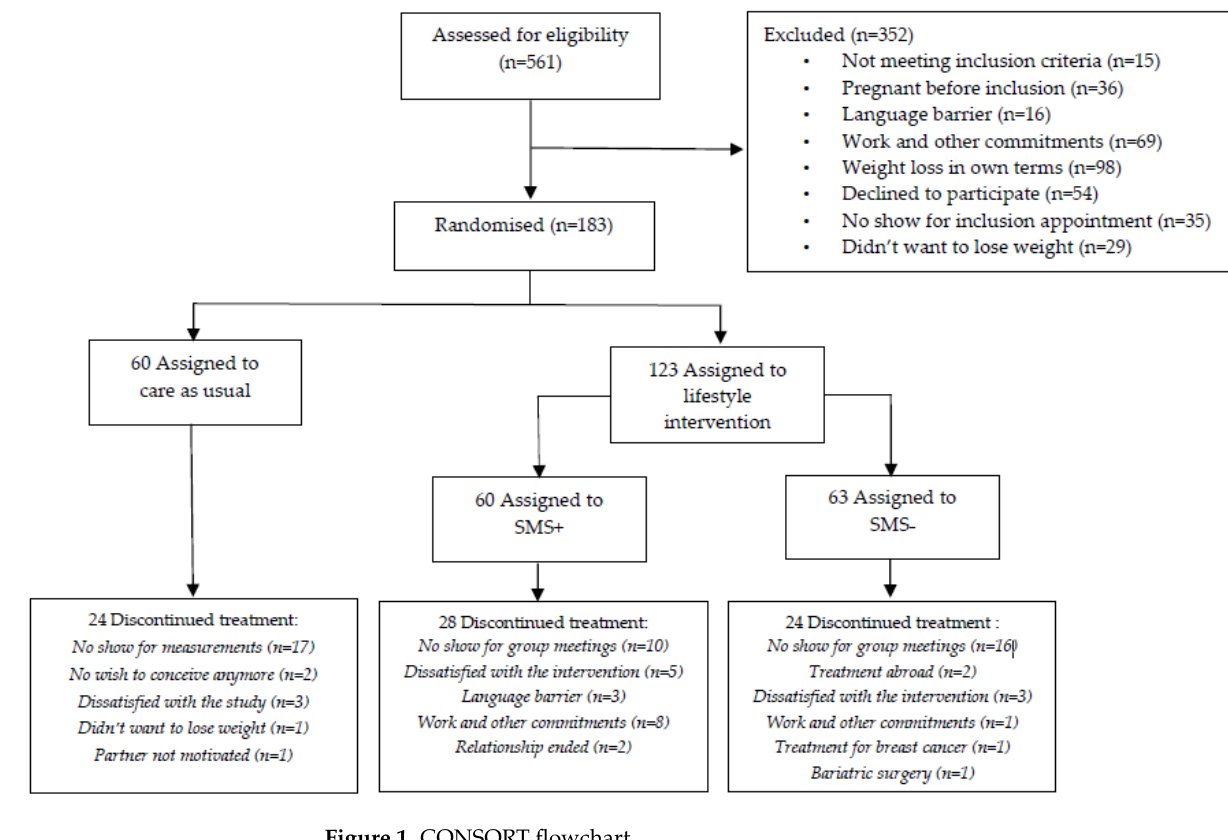
Figure 1. CONSORT flowchart. Table 1. Baseline characteristics.